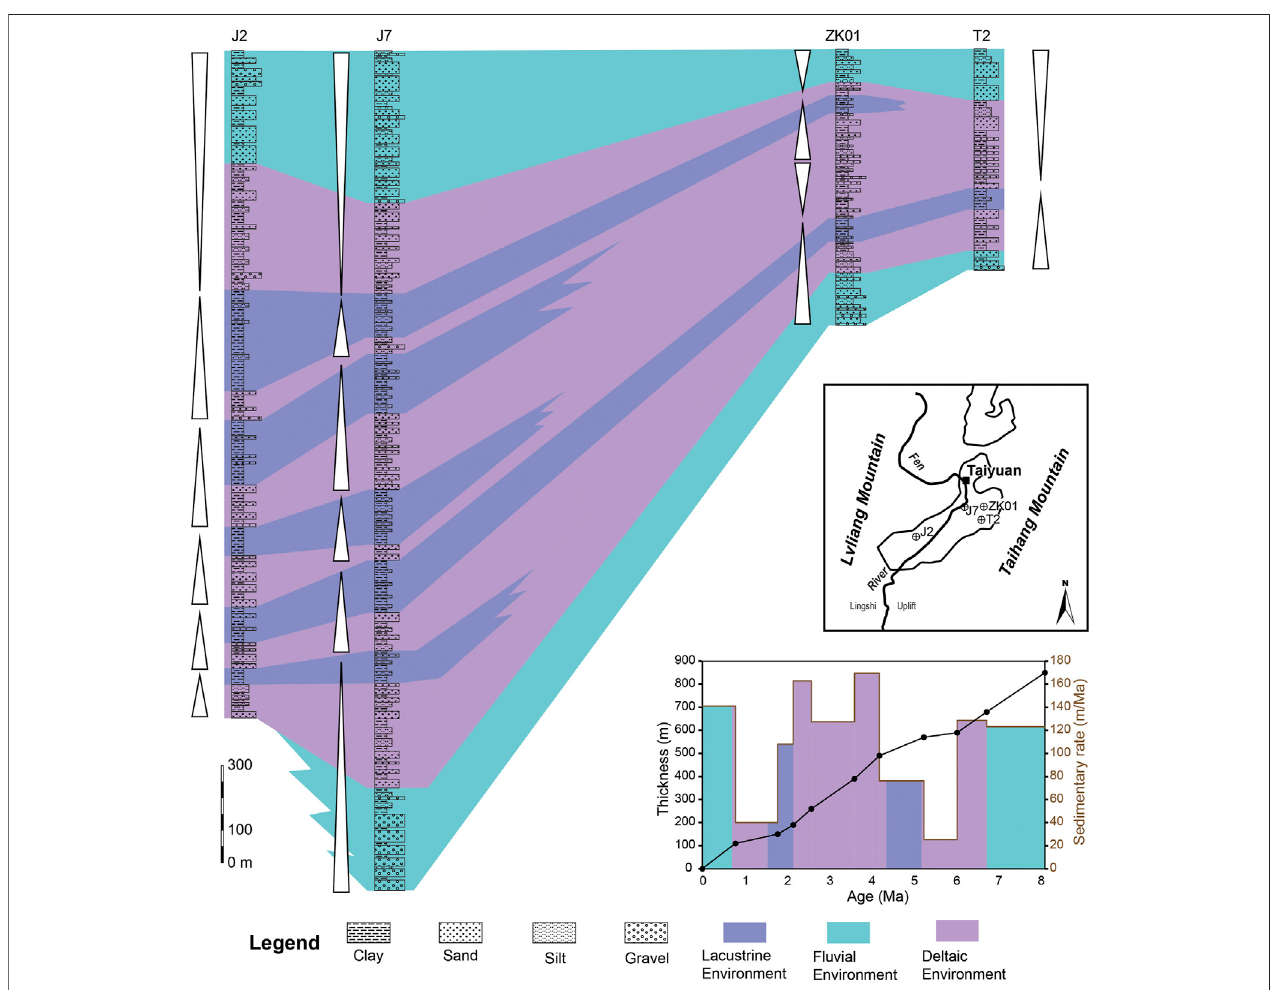
FIGURE 6 | Correlation of stratigraphy and sedimentary environments from boreholes in Taiyuan Basin. The simpli fi ed geological map shows the location of the boreholes. The bottom right corner displays sedimentary rates of ZK01.